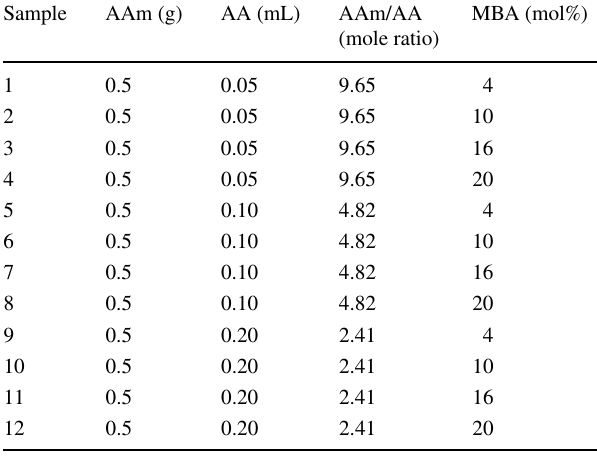
Table 1 Synthesis conditions of PPG